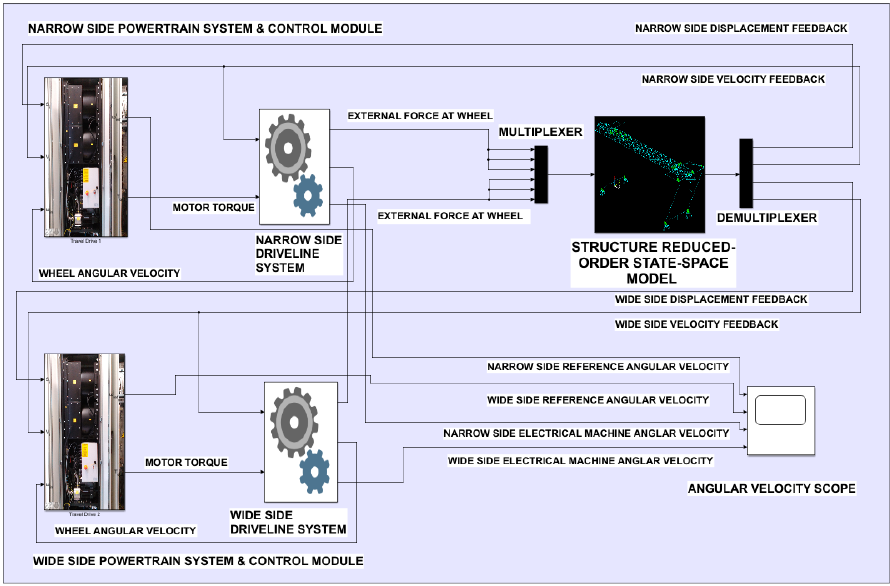
Figure 4. Simulation Model for the Structure in